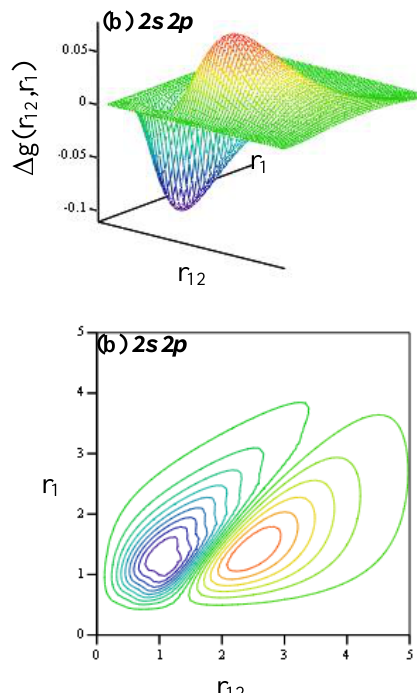
,r ) evaluated from 12 1